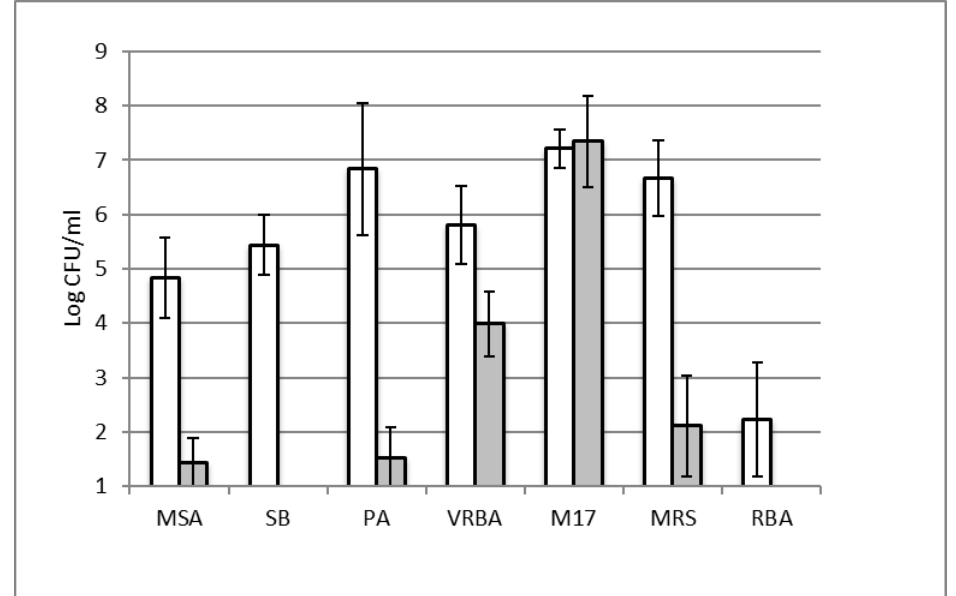
Figure 1. Microbiological counts for the considered bacterial groups in summer (white bars) and autumn (grey bars) cheese productions. MSA mannitol salt agar for staphylococci, SB Slanetz & Bartley medium for enterococci, PA Pseudomonas agar for Pseudomonas , VRBA violet red bile agar for Enterobacteriaceae , M17 agar for S. thermophilus , MRS De Man Rogosa and Sharpe agar for heterofermentantive lactobacilli, RBA Rosa Bengala for yeasts and